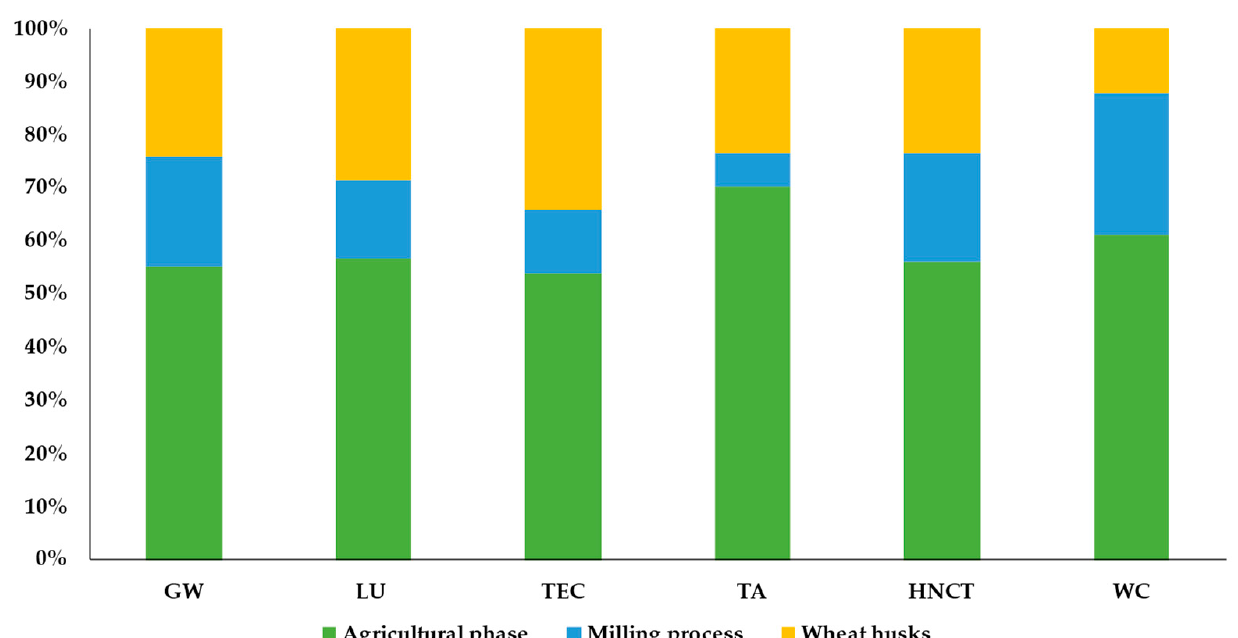
Figure 8. Percentage contribution (%) of each wheat process life cycle stage to environmental impact categories. GW, global warming; LU, land use; TEC, terrestrial ecotoxicity; TA, terrestrial acidification; HNCT, human non-carcinogenic toxicity; WC, water